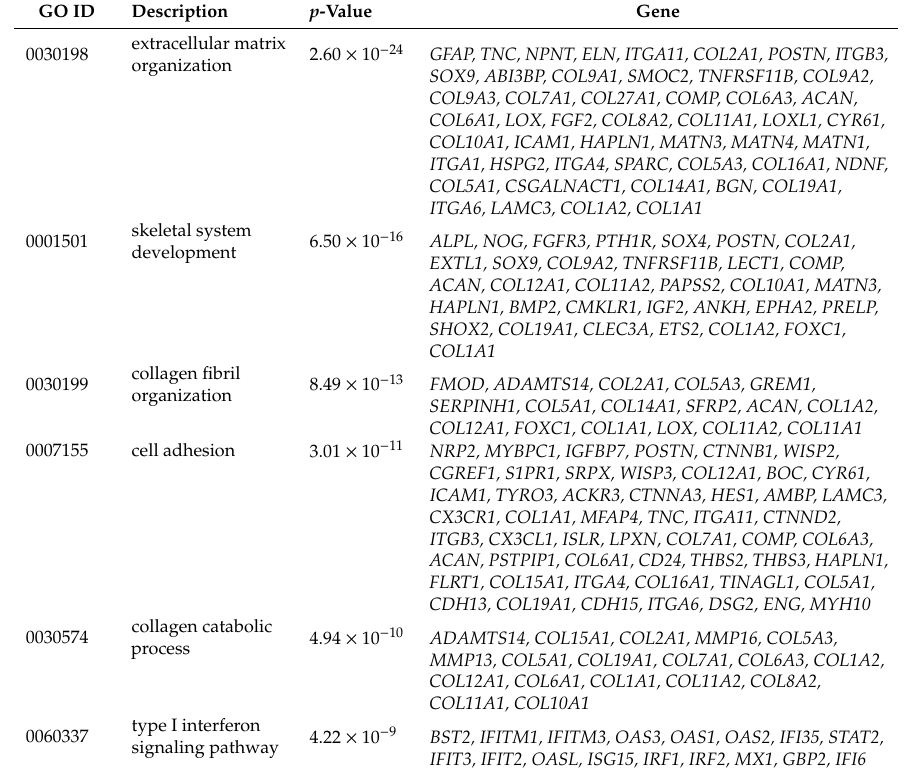
Table 1. Analysis of gene ontology (GO) biological process of di ff erentially expressed genes (DEGs).